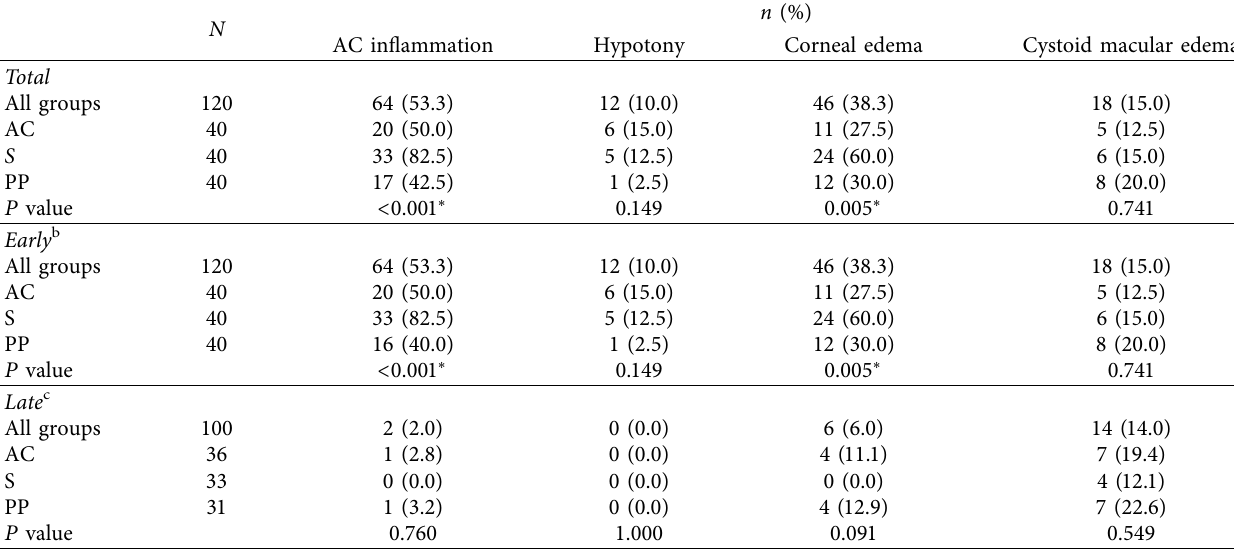
Table 8: Complication rates a